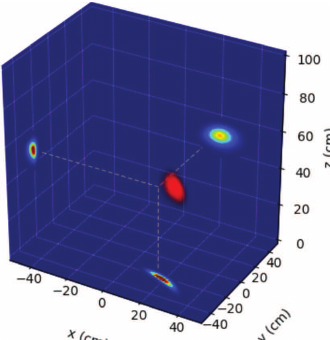
Fig. 3. 3D representation of the localisation of a 1.3 µ Ci Cf- 252 source. The source was placed inside a lead cylinder with a 16 mm radial thickness and 105 mm height at a position ( x, y, z ) = (20 , − 30 , 52) cm and measured for 10 s. See text for details.